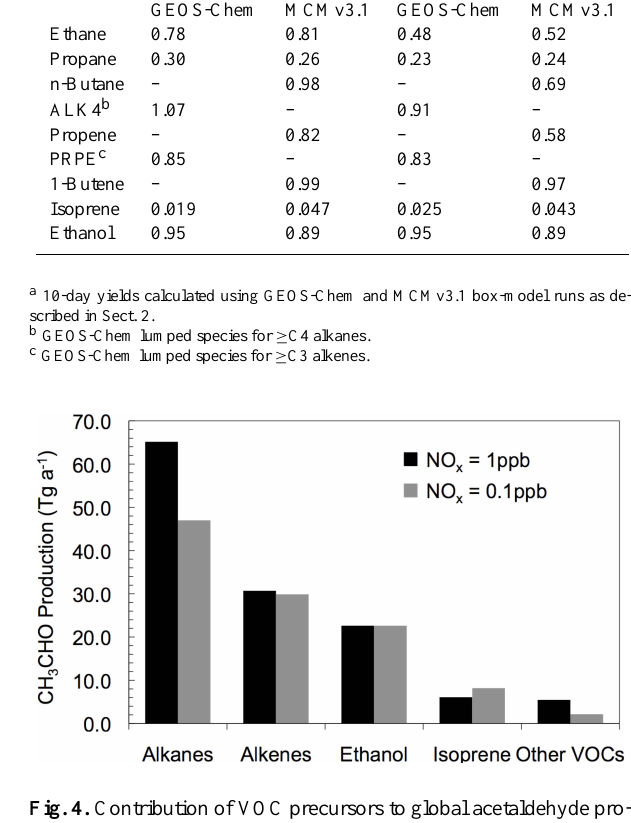
Fig. 4. Contribution of VOC precursors to global acetaldehyde pro- duction calculated using the GEOS-Chem high-NO x and low-NO x 10-day